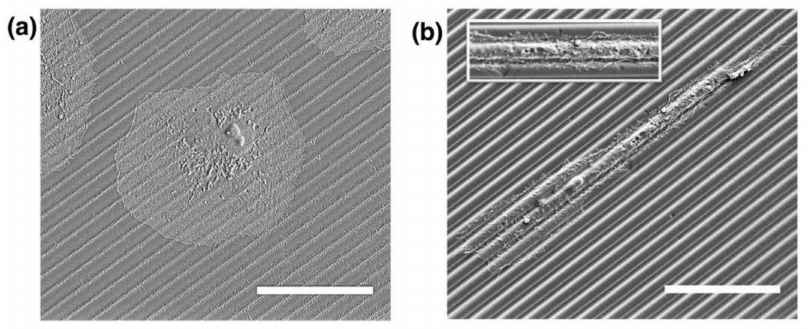
Figure 6. SEM images showing the morphology of kidney epithelial cells (Vero) cultured on 4.5 µ m period photoembossed patterned substrates using ( a ) the conventional photoembossing protocol (exposure at RT and development at 80 ◦ C) and ( b ) the modified photoembossing protocol (exposure and development at 80 ◦ C). Inset in ( b ) shows detail of filopodia. Scale bar 30 µ